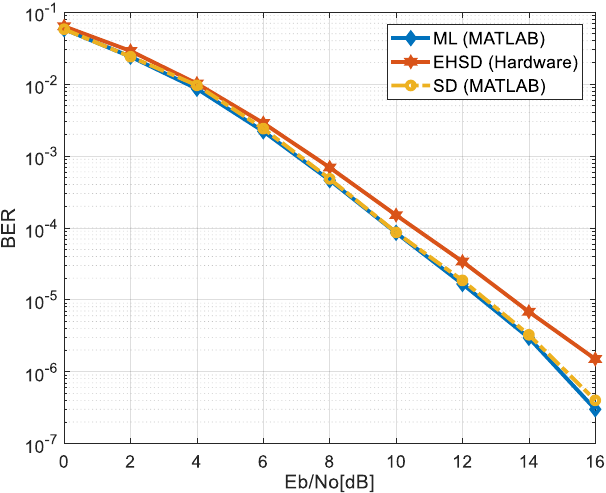
Figure 12. Verification platform of the EHSD using Vivado Simulator and MATLAB